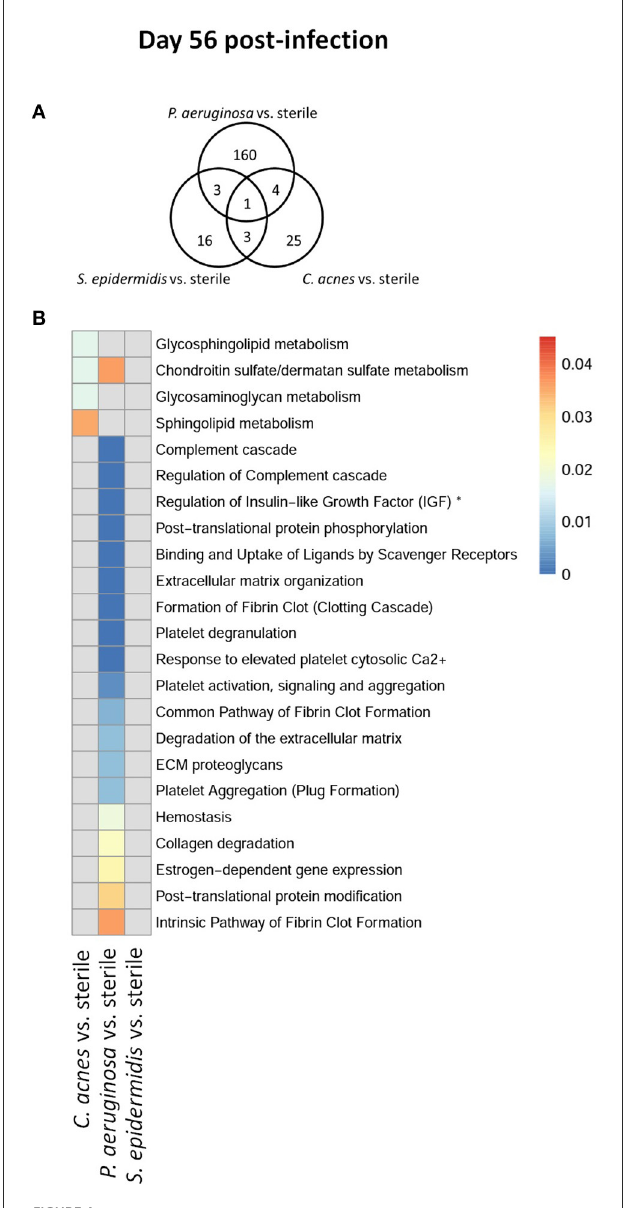
FIGURE4 Quantity of differentially expressed proteins in P. aeruginosa , C. acnes , and S. epidermidis infection and overlap between infection types at the late time point, day 56 post-infection (A) as well as functional enrichment (B) . *Represents abbreviation of regulation of Insulin-like Growth Factor (IGF) transport and uptake by Insulin-like Growth Factor Binding Proteins